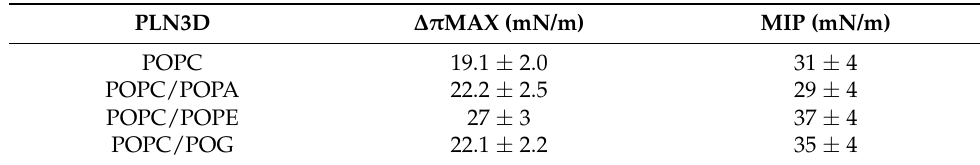
Figure 5. Insertion isotherms for: ( a ) The C-terminus of perilipin 3 (PLN3D) as a function of lipid packing for POPC (black circle), 7:3 POPC/POPA (red diamond), 7:3 POPC/POPE (blue square), and 7:3 POPC/POG monolayers (green triangle); ( b ) full-length perilipin 3 (PLN3A) as a function of lipid packing for POPC (black circle), 7:3 POPC/POPA (red diamond), 7:3 POPC/POPE (blue square), and 7:3 POPC/POG monolayers (green triangle). Error bars are the standard deviation of surface pressure values after drop expansion/contraction ( π Lipid ) and after addition of protein ( Δπ Protein ). Table 2. Maximum change in monolayer pressure on triolein drop, ∆ π MAX , and maximum insertion perilipin 3. Uncertainty values represent 95% confidence intervals.